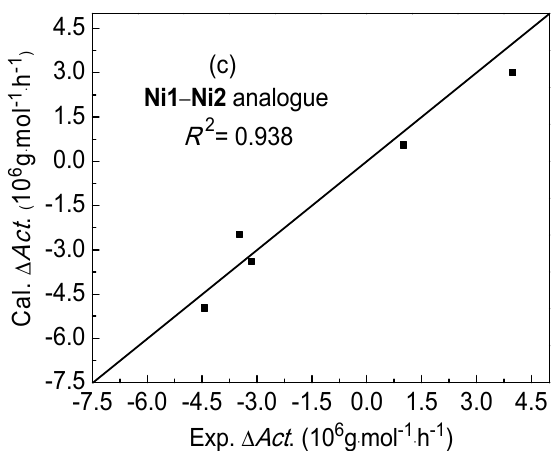
Figure 2. Comparisons between calculated and experimental activities of ( a ) Ni1 system, ( b ) Ni2 system, and ( c ) Ni1 ‒ Ni2 analogue system, by the descriptors of effective net charge ( Q eff ) and open cone angle ( θ ). Table 9. Standardized values of e ff ective net charge ( Q e ff ) and open cone angle ( θ ) along with the values of catalytic activities of Ni1 complexes, Ni2 complexes and the analogue Ni1 – Ni2 system.